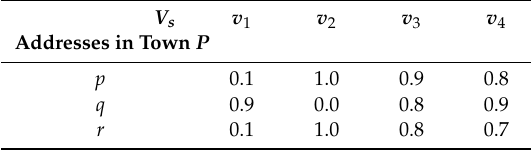
Table 2. Attribute value appurtenance fuzzy degree function for s ∈ A on Town P ( d s ).